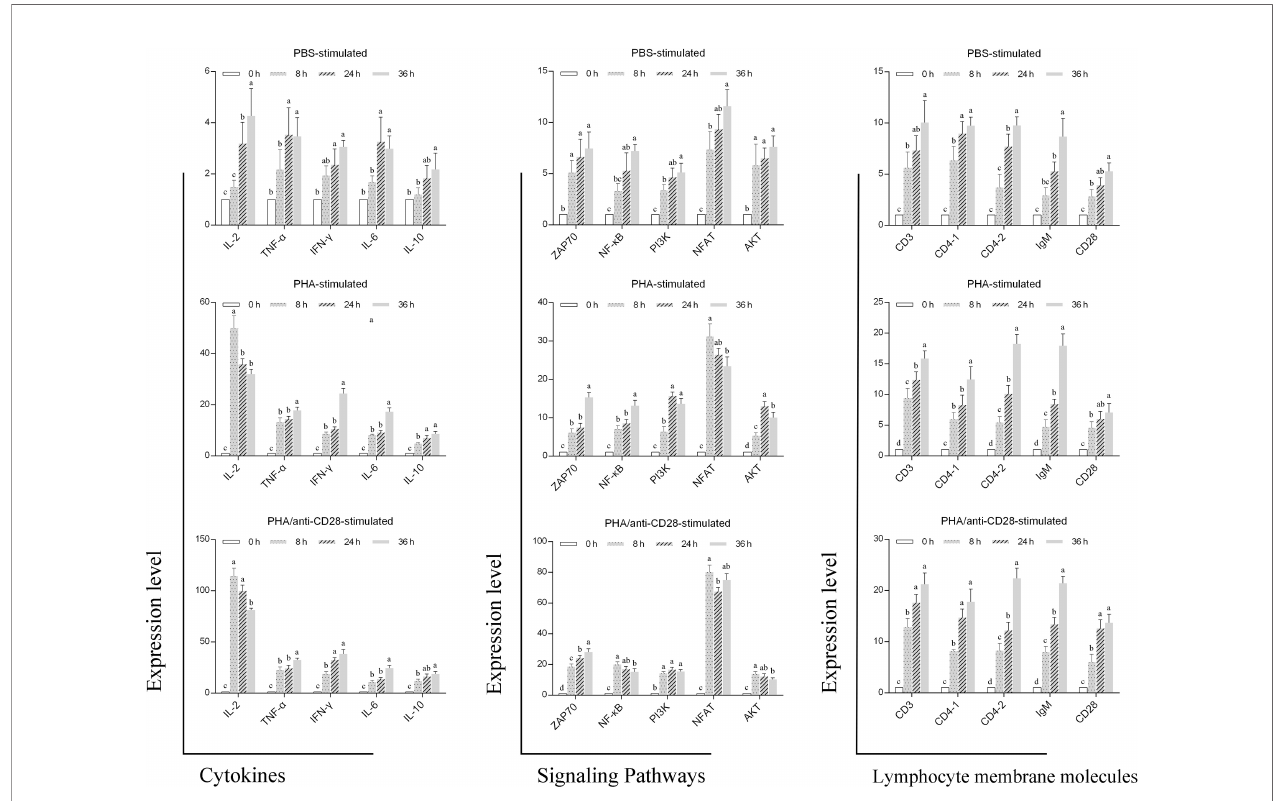
FIGURE 9 | Gene expression. RT-PCR analysis of genes related to leukocyte membrane molecules, signaling pathways, and cytokines after 0, 8, 24, and 36 h of treatment of PBS, 5 m g/ml PHA or 5 m g/ml PHA +0.5 m g/ml anti-CD28 Abs. Data are expressed as SD. Data are from nine independent individuals; different letters represent the statistical signi fi cance ( p <